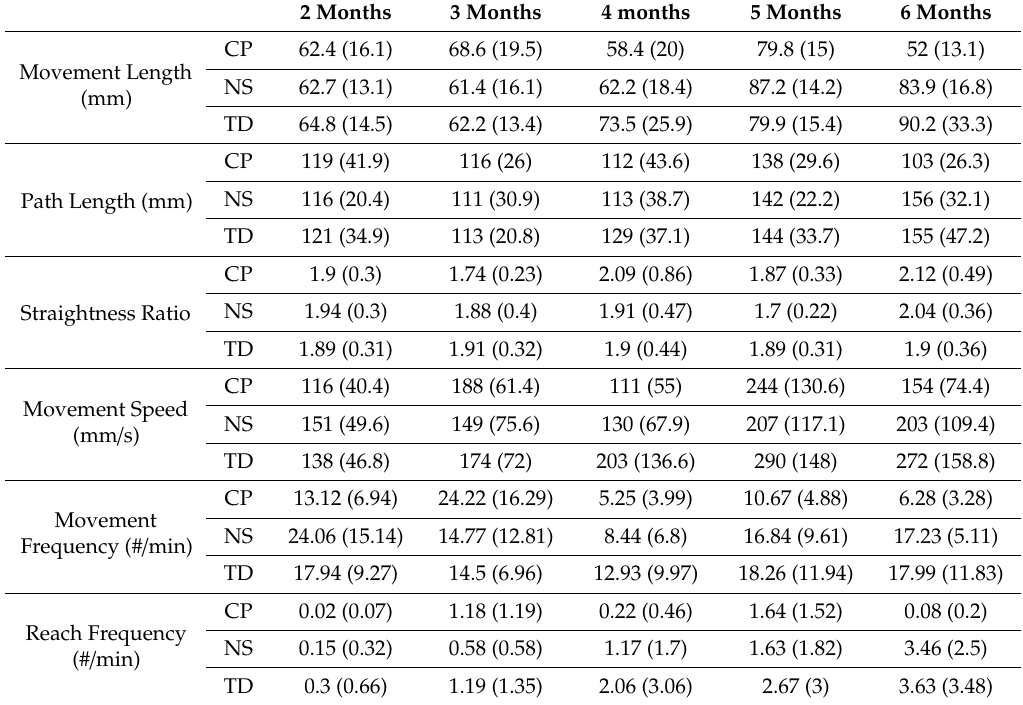
Table 1. Overall group mean (standard deviation) of the kinematic variables at 2–6 months of